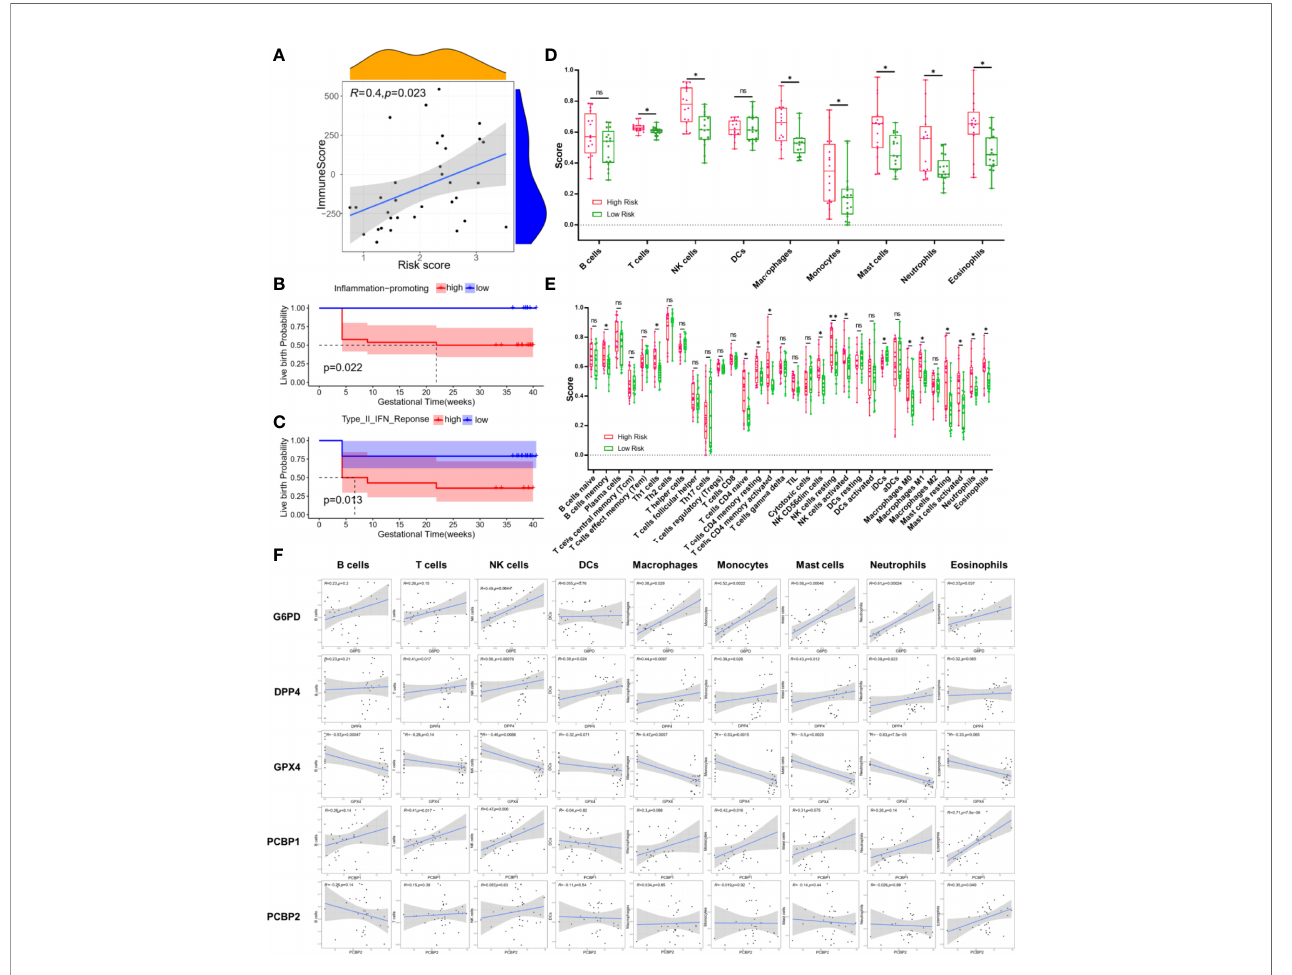
FIGURE 5 | Immune microenvironment